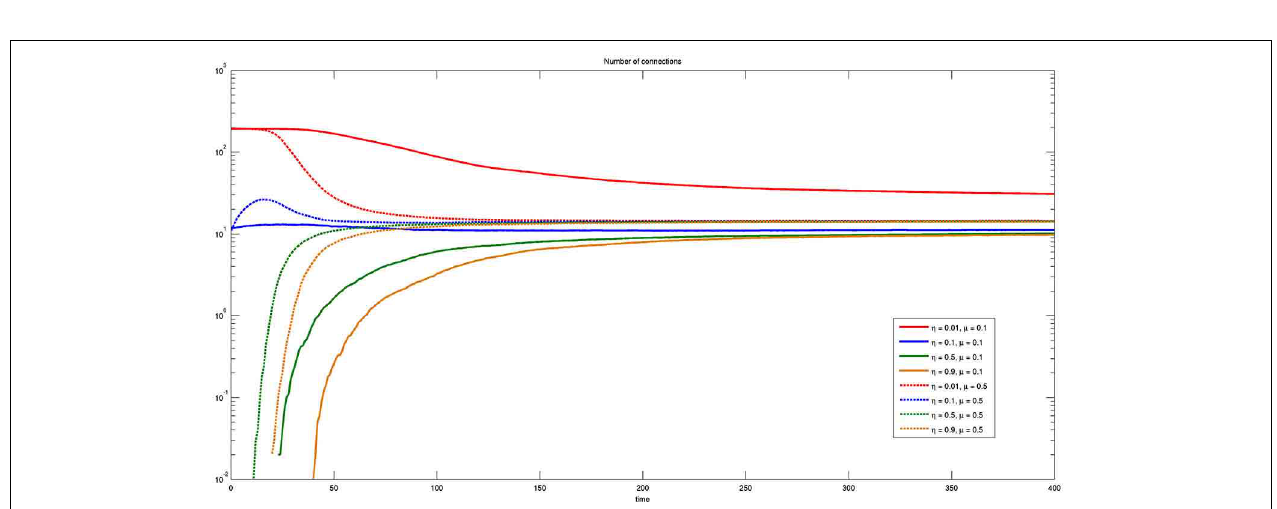
FIGURE 11 | Time course of the number of connections for different values of η and μ . Here η = { 0 . 01 , 0 . 1 , 0 . 5 , 0 . 9 } and μ = { 0 . 1 , 0 . 5 } . Some connections are present at the initial time when the threshold η is sufficiently